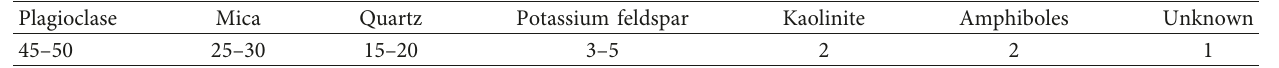
Table 2: Mineral composition (%) of the tonalite